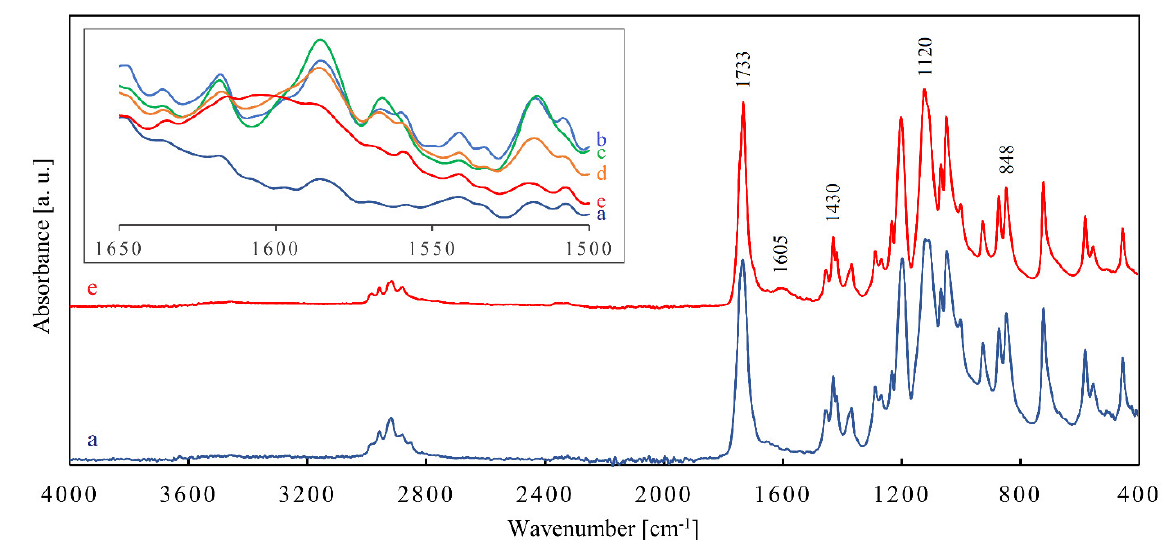
Figure 7. Averaged Fourier transform infrared spectra of the ( a ) non−degraded stent and ( e ) 24−weeks−degraded stent. The inset shows small changes in spectra observed as the degradation progressed: ( a ) non−degraded, ( b ) 4−weeks−degraded, ( c ) 8−weeks−degraded, ( d ) 16−weeks−degraded and ( e ) 24−weeks−degraded stent.